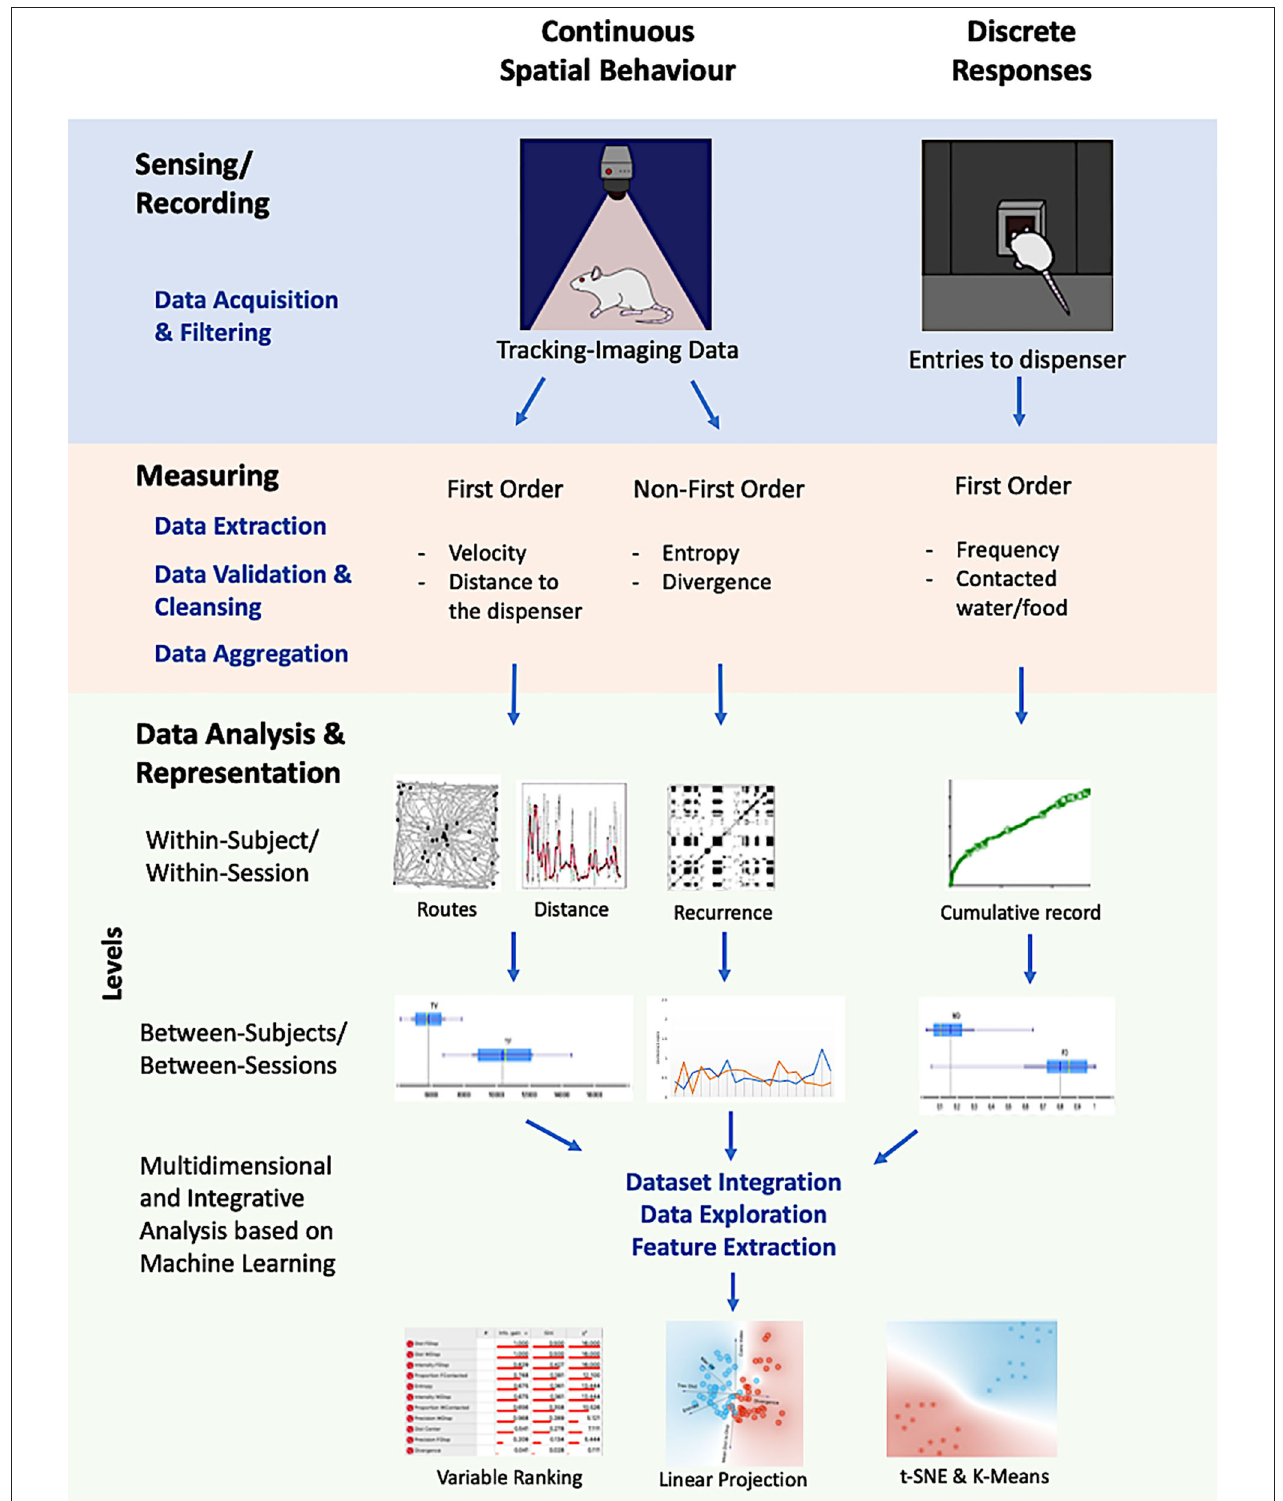
FIGURE 1 | Graphical representation of the proposed integrative, multilevel, and multidimensional approach. It integrates recordings for continuous spatial behavior (based on machine vision), discrete responses of the organisms with multiple measures for each one, multilevel data analysis (within-subject, within-session, between subjects, between sessions), and a multidimensional characterization of the unitary system between spatiotemporal dynamics and discrete responses.